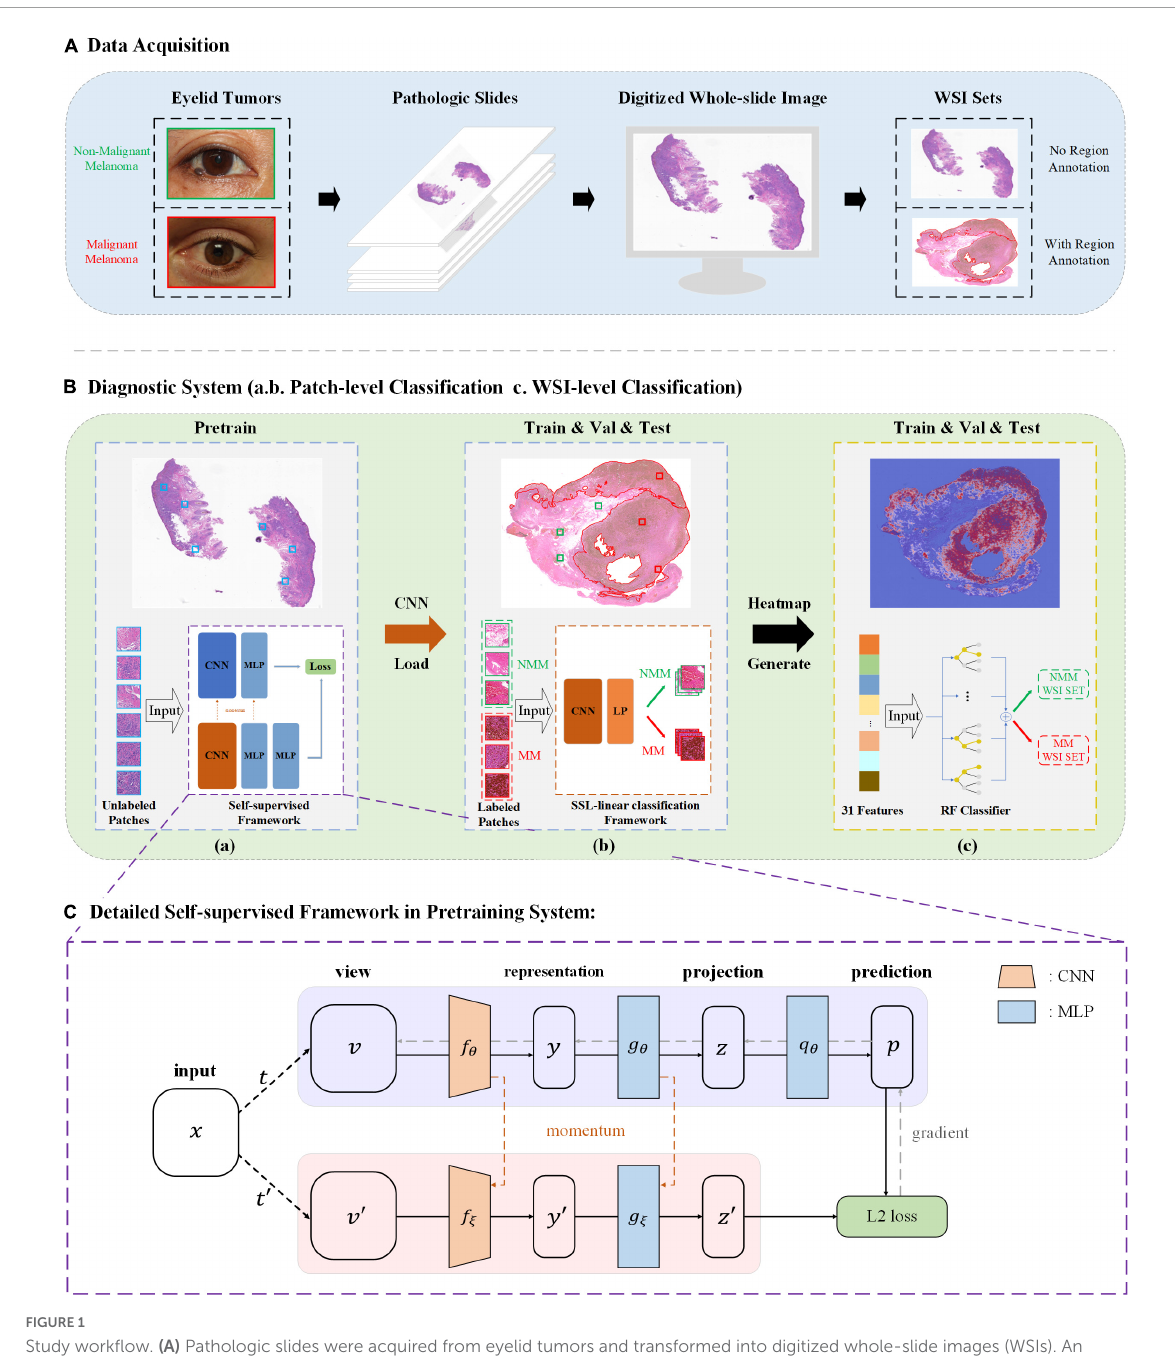
FIGURE1 Study workflow. (A) Pathologic slides were acquired from eyelid tumors and transformed into digitized whole-slide images (WSIs). An experienced pathologist labeled ∼ 25% WSIs by delineating the tumor areas in WSIs. (B) Diagnostic system. (a) Pretraining is based on Bootstrap Your Own Latent (BYOL), a new approach to SSL. Patches from unlabeled WSIs were input into two identical convolutional neural networks (CNNs) with two different sets of weights for learning features and comparing the outputs with each other as pretraining. A load of learned image representation was then generated. (b) Training for patch-level classification. Patches from labeled WSIs (training and validation sets) were input into a CNN for training together with the load from the pretraining round, and training weights were acquired. The diagnostic ability of patch-level images was evaluated in the testing set. A value of the malignancy probability of every patch is then generated (not shown). (c) Extrapolation to image-level classification. Patches were embedded back into the corresponding WSIs, and by feeding back the malignancy probability of every patch, a probabilistic heatmap for WSIs was generated. Based on the predicted patch value, the threshold transformation was used to extract 31 features. The WSI-level classification based on random forest (RF) was then assigned. (C) BYOL architecture. In 2 CNNs ( f θ and f ξ ) with a different set of weights, θ are the trained weights, and ξ is an exponential moving average of θ . At the end of the training, parameter θ is acquired with the minimum of L2 loss, and y is used as the learned representation—Val, validation; MLP, multilayer perceptron; MM, malignant melanoma; NMM, non-malignant